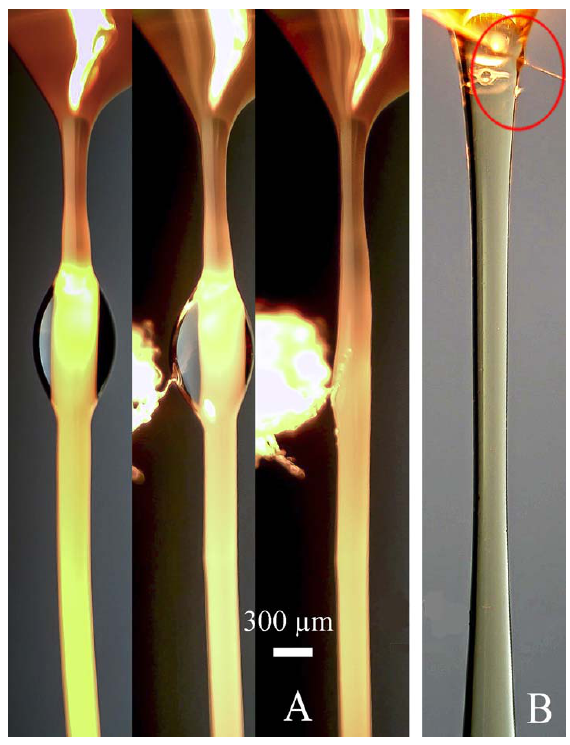
Figure 7. Enlarged images of solvent droplets on fiber surfaces for CPABI in DMAc solution ( A ) and PAN in DMSO solution ( B ).